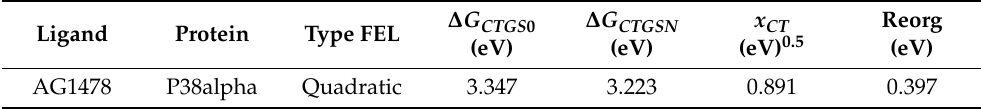
Figure 5. REES curves for kinase inhibitor–kinase complexes. ( A ) p38 α kinase-AG1478 complex (sigmoidal fit, black symbols). Inset: REES data (open circles), fit to quadratic FEL model (solid line), fit to linear FEL model (dashed line), fit to cubic FEL model (dotted line). ( B ) APH2 aminoglycosidase- AG1478 complex (sigmoidal fit, grey line). Inset: REES data (filled circles), fit to quadratic model (solid line), fit to linear model (dashed line), fit to cubic model (dotted line). REES data (peak emission wavelength as a function of excitation wavelength) were from [17]. Structure of the ligand, AG1478, is indicated in the figure. Table 1. Fit photophysical parameters for ligand from red-edge excitation spectroscopy (REES) curve. (Reorg denoted reorganization energy, other abbreviations/symbols defined in main text).